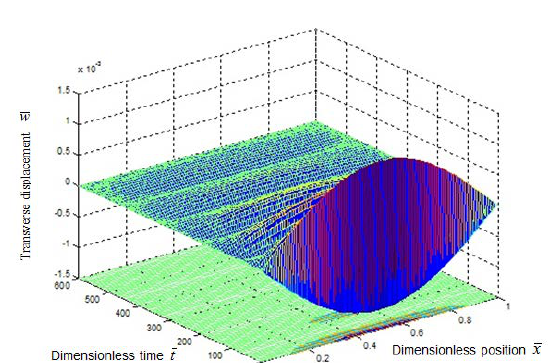
¯ w Figure 14. Dynamic response of the transverse displacement 1 = profile for the case R i = 0 . 41 m,γ = 0 . 03 ,n = 1 ,δ 0 . 3721 , ¯ U = 0 . 01 , Θ = 100 ◦ C,χ 1 = − 0 .